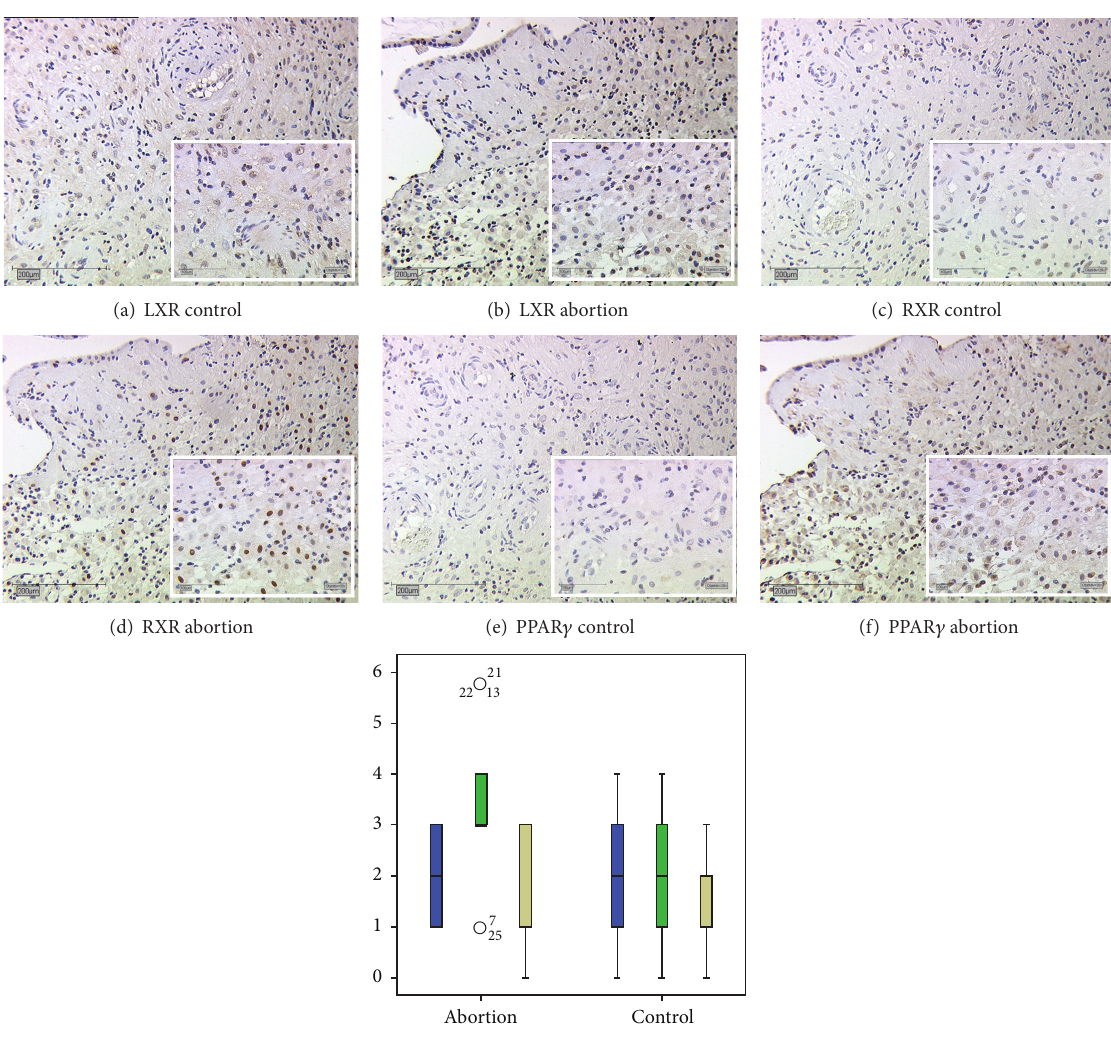
Figure 4: Serial sections of LXR ((a), (b)), RXR 𝛼 ((c), (d)), and PPAR 𝛾 ((e), (f)) expression in decidua of placentas from regular pregnancies ((a), (c), (e)) and in placenta of miscarriage ((b), (d), (f)). All magnifications are 20x lens. Box plots represent the LXR, RXR, and PPAR expression in decidua of spontaneous abortion and control decidua derived from serial sections (g). The boxes display the range between the 25th and 75th percentile and the horizontal line indicates the median. The bars represent the 5th and 95th percentiles. Circles indicate values which are more than 1.5 times the box length. Asterisks indicate values which are more than 2 times the box length. Isotypic controls for the antibodies are shown in Figure